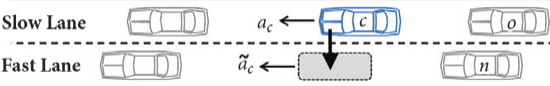
Fig. 6. Lane changing with the MOBIL model: a c –